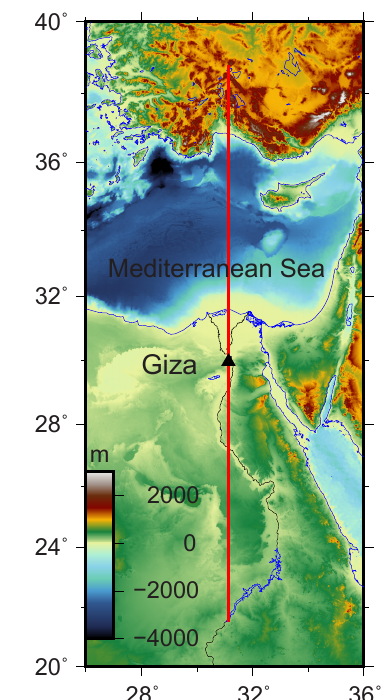
Figure 1. Topography of the study area (Becker et al., 2009). Black triangle: the location of the Giza pyramids, towards the north of the River Nile in Egypt. Red line: location of the profile in Fig. 2c. The presence of the Mediterranean Sea contributes to a southward deflection of the vertical at Giza, to the south, but the difference in the effect between nearby stations is